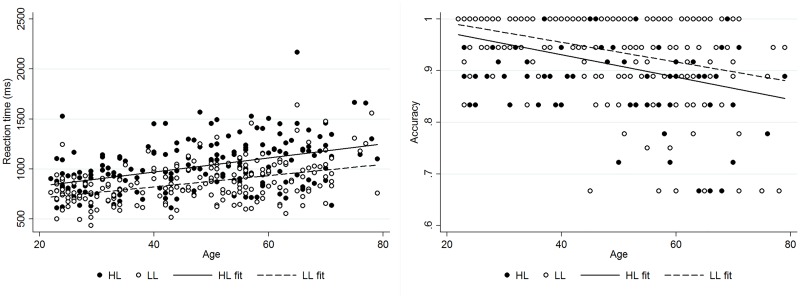
Task performance.HL = high load, LL = low load.